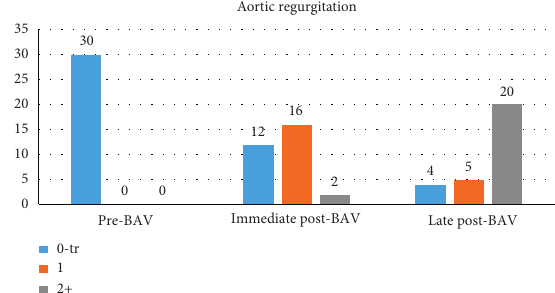
Figure 4: Distribution of the degree of aortic regurgitation (AR) before and after dilation among all patients (0: none to trivial AR, 1: mild AR, 2: more than mild AR).